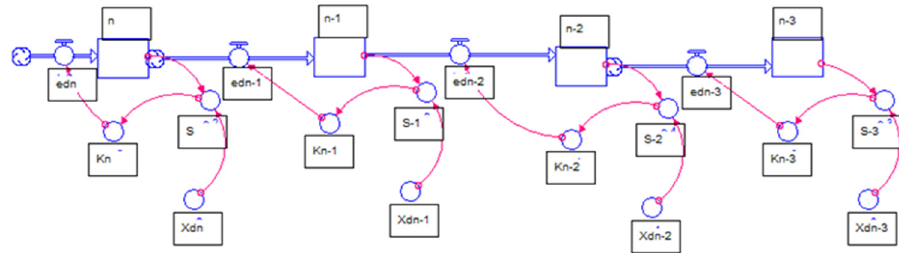
Figure 39. Forrester diagram of n, state variables.